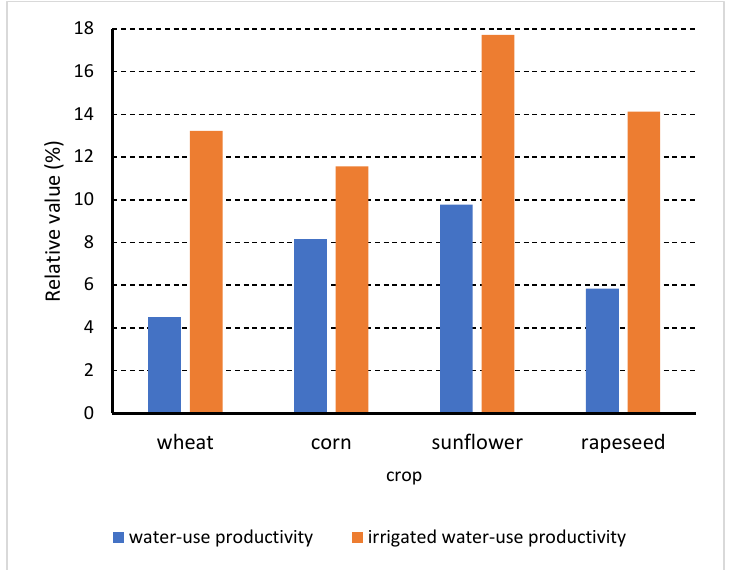
Figure 5. A relative increase in water-use productivity of smart irrigation systems compared to conventional ones.